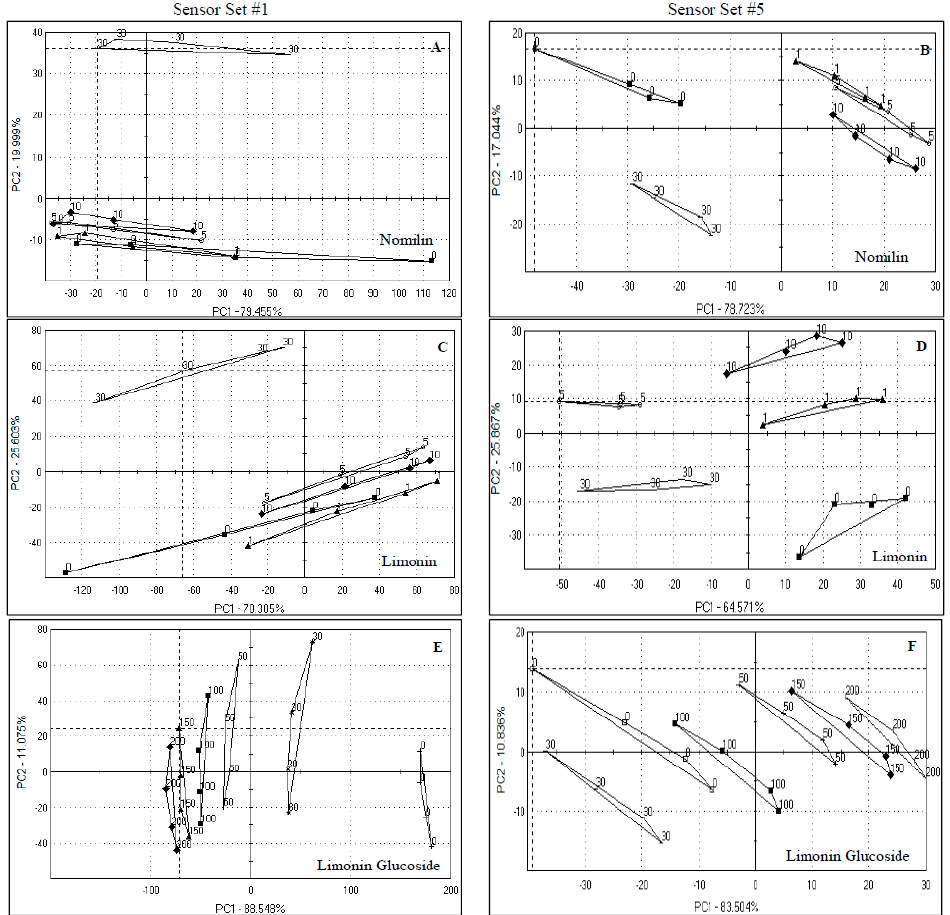
Figure 3. Principal component analysis of orange juice spiked with nomilin, limonin and limonin glucoside. Numbers in the graphs indicate the concentrations used (µg/mL juice). Samples presented were analyzed by sensor set #1 and 5. ( A ) Nomilin by Set #1; ( B ) Nomilin by Set #5; ( C ) Limonin by Set #1; ( D ) Limonin by Set #5; ( E ) Limonin glucoside by Set #1; ( F ) Limonin glucoside by Set #5.